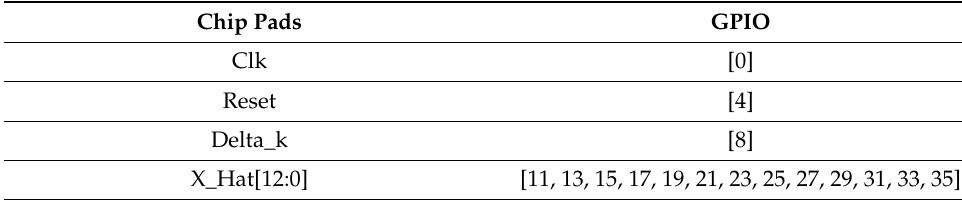
Table 9. Corresponding Table of Chip Pads and GPIO Pins. Chip